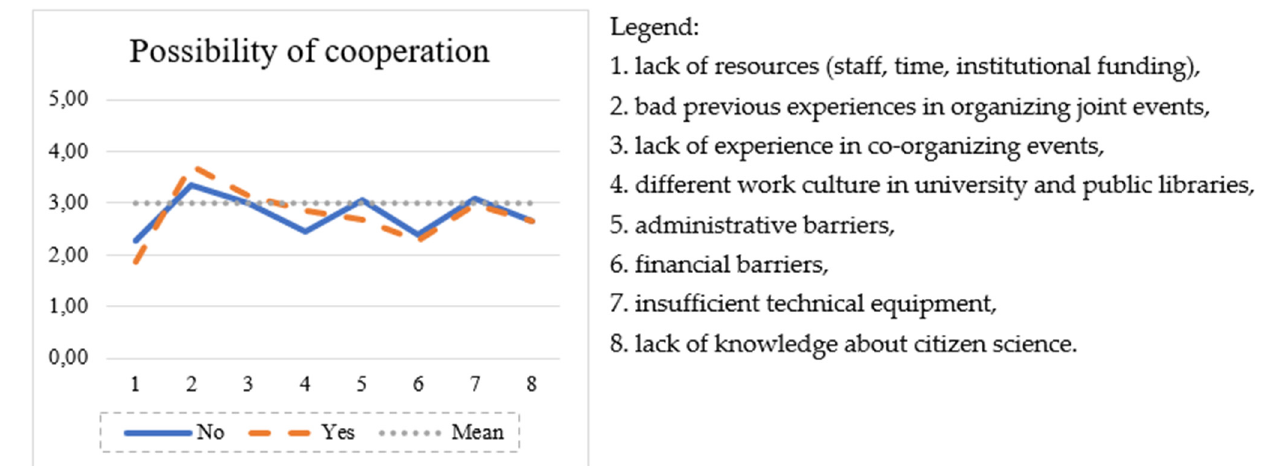
Figure 3. Possibility of cooperation.